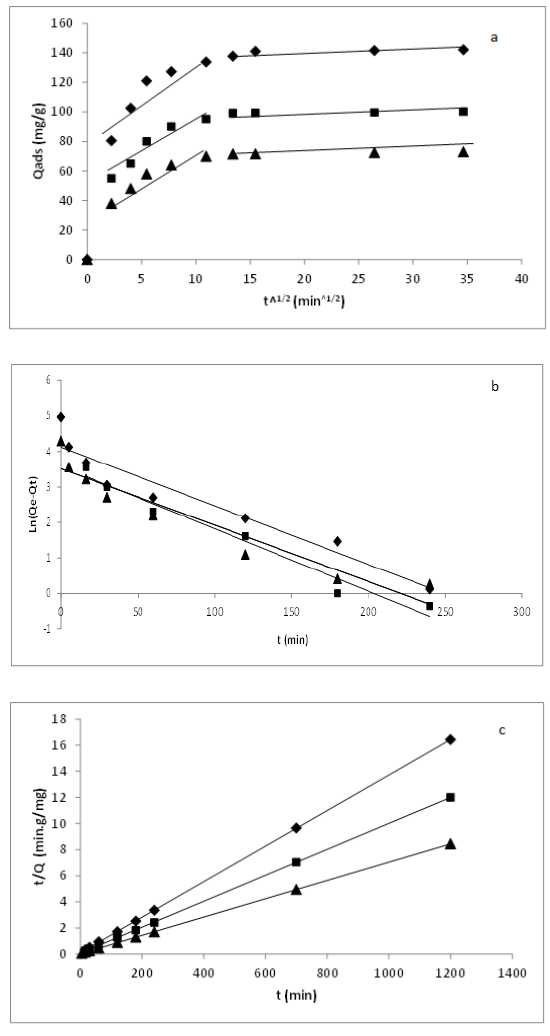
Figure 5. The kinetics models for adsorption of Chromium on acti- vated carbon at different concentrations at 298 K: (a) in- terparticlediffusionkinetics; (b)pseudofirstorderkinetics; (c) pseudo second order kinetics.